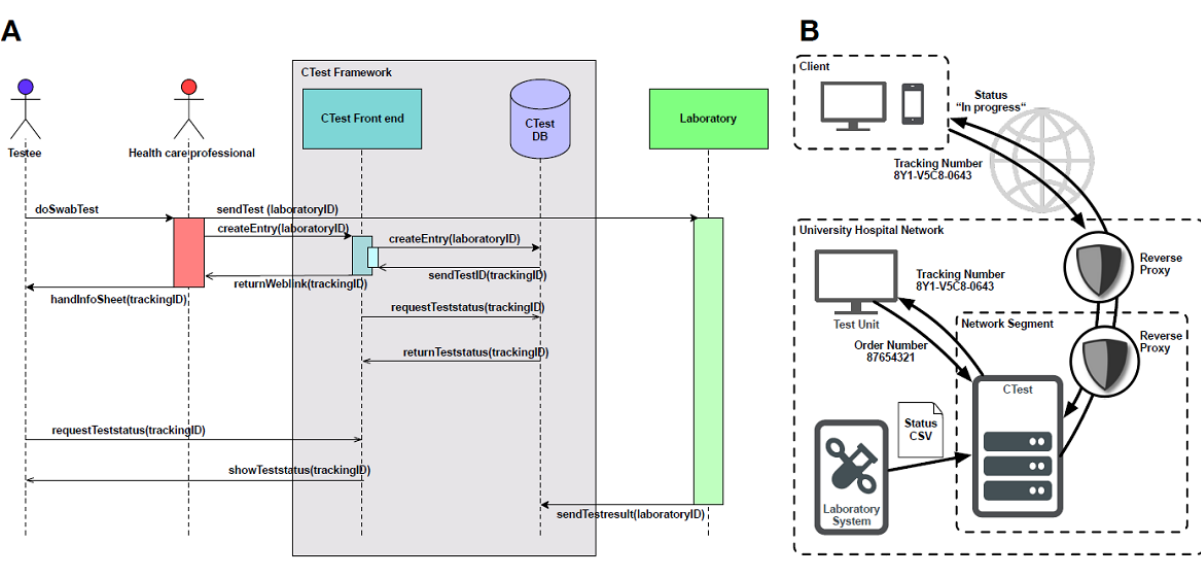
Figure 2. COVID-19 test procedure and setup. (A) The left-hand panel shows the detailed process flow of the COVID-19 tests. CTest (gray) is tightly integrated into the test process. The test framework comprises a web-based front end (turquoise) and a Clojure back end, including a mySQL (Structured Query Language) database (DB) (purple). After the swab test for COVID-19, the health care professional creates a CTest entry via entering the laboratory ID in the CTest front end. Based on that, a secure tracking ID is created by the back end and a corresponding personalized URL is created. CTest then automatically creates a test-specific information sheet for each testee. This sheet contains the test-specific weblink and a QR (Quick Response) code, both based on the tracking ID. The URL does not provide any information to track back the test results to the corresponding testee (blue). Via this URL, a testee can request the corresponding test status at any time. After the analysis in the laboratory, results are transmitted to the CTest database. The CTest front end automatically updates the status on the test-specific weblink based on the corresponding test results. (B) In the right-hand panel, a possible integration scenario of CTest into a clinical infrastructure is shown. CTest runs on a virtual machine within the secured network of a university hospital. The external hostname, with weblinks to the testee's status, is forwarded via reverse proxy. A second reverse proxy forwards the port to the application to a nonprivileged port. Thus, the application does not need to run with a system user. Inside the hospital's network, the test unit communicates to the CTest server to create new test cases via an order number. The CTest server returns back the tracking number and the corresponding weblink and QR code. The laboratory pushes test results as comma-separated values (CSV) files to the CTest server. The test-specific webpage content is then updated according to the test